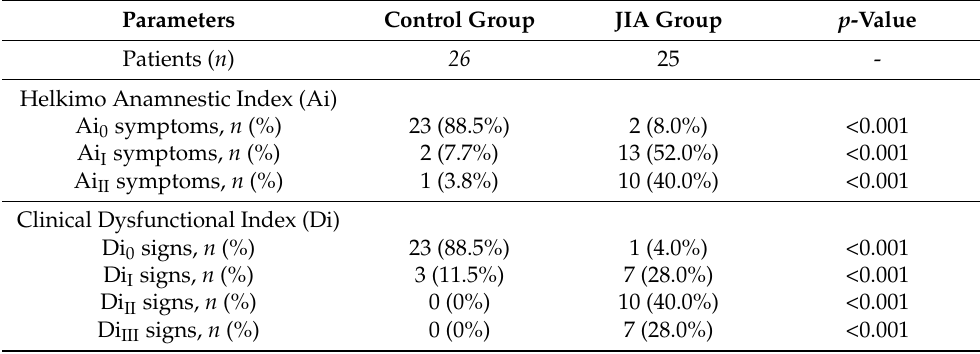
Table 4. Helkimo anamnestic and clinical dysfunction indexes in the two groups.